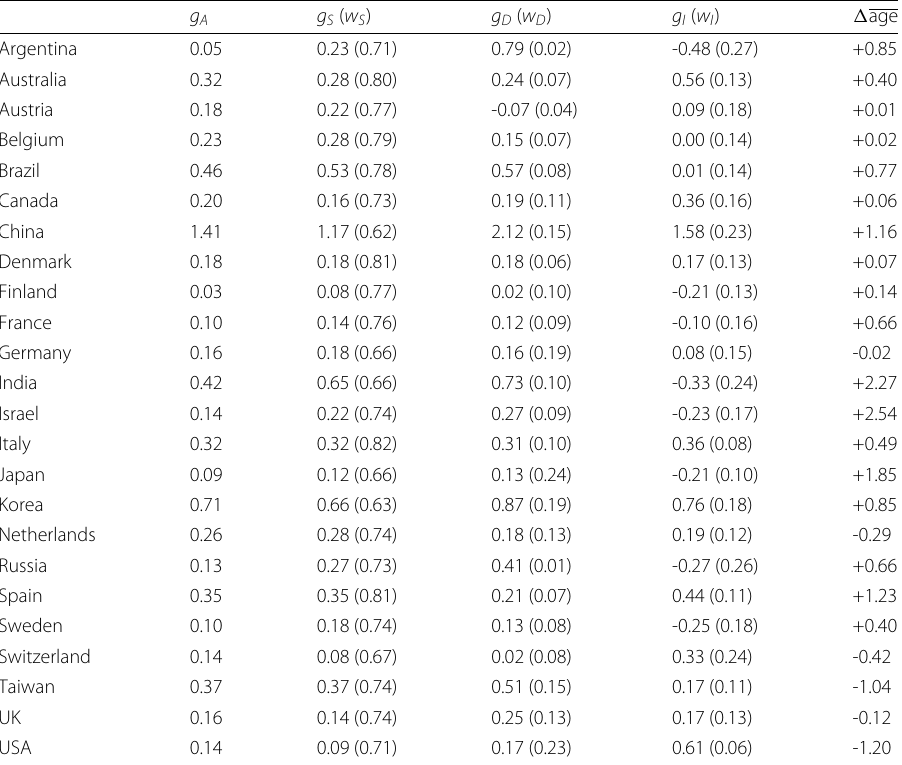
Table 2 National scientific output growth for selected countries g A g S ( w S ) g D ( w D ) g I ( w I ) (cid:2)